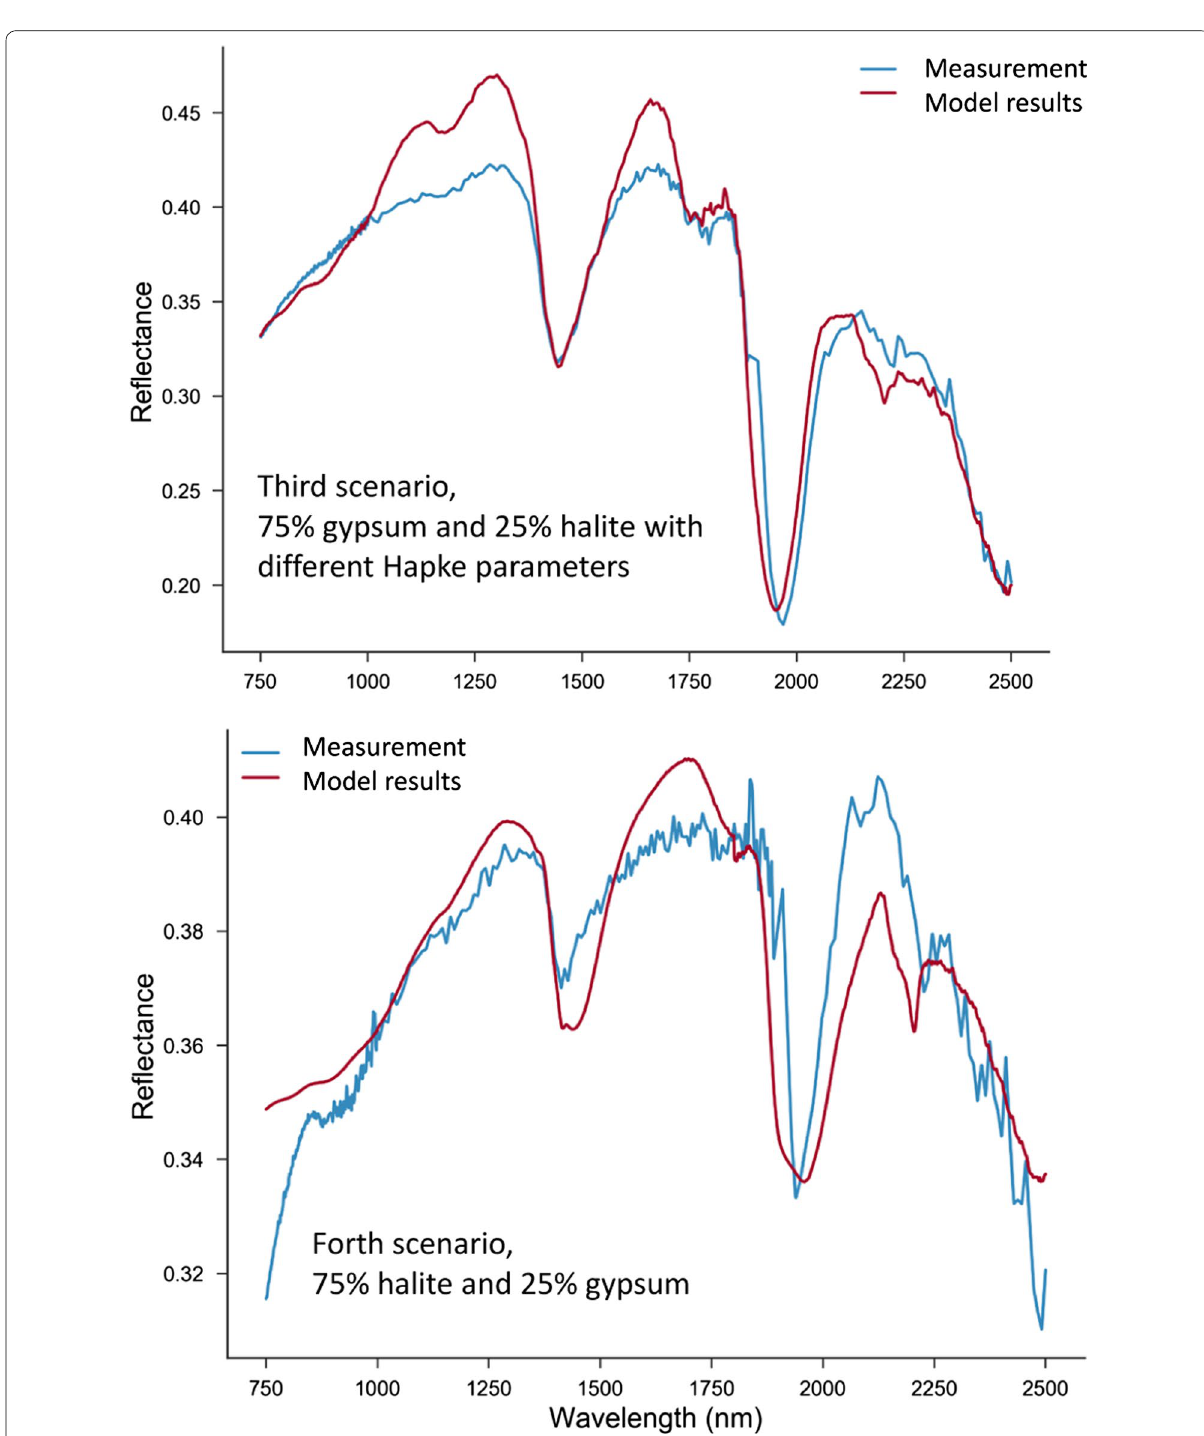
Fig. 9 Comparison between the modeled and measured spectra for the third and forth mixing